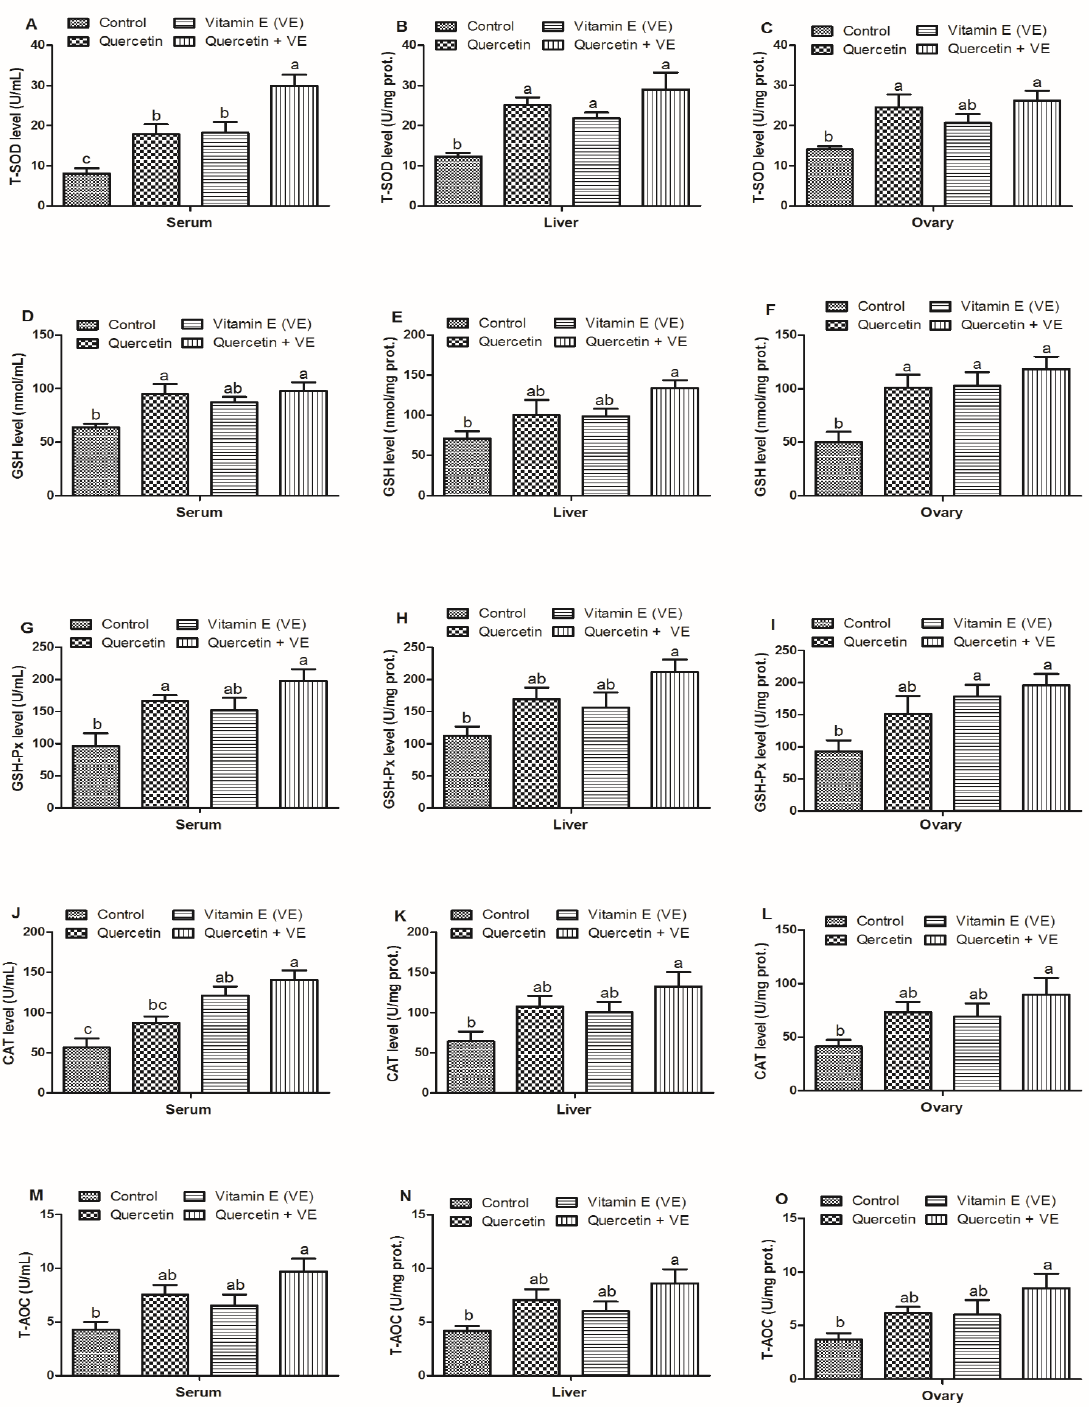
Figure 4. Effects of quercetin, vitamin E, and quercetin + vitamin E on the antioxidant capacity of the liver, blood and ovary of aging breeder hens. Levels of total antioxidant capacity (T-AOC) ( A – C ), concentrations of glutathione (GSH) ( D – F ), glutathione peroxidase (GSH-Px) ( G – I ) , catalase (CAT) ( J – L ), and total superoxide dismutase (T-SOD) ( M – O ). The values are presented as the mean ± SD. Bars without the same letter differed significantly ( p < 0.05). prot: protein.